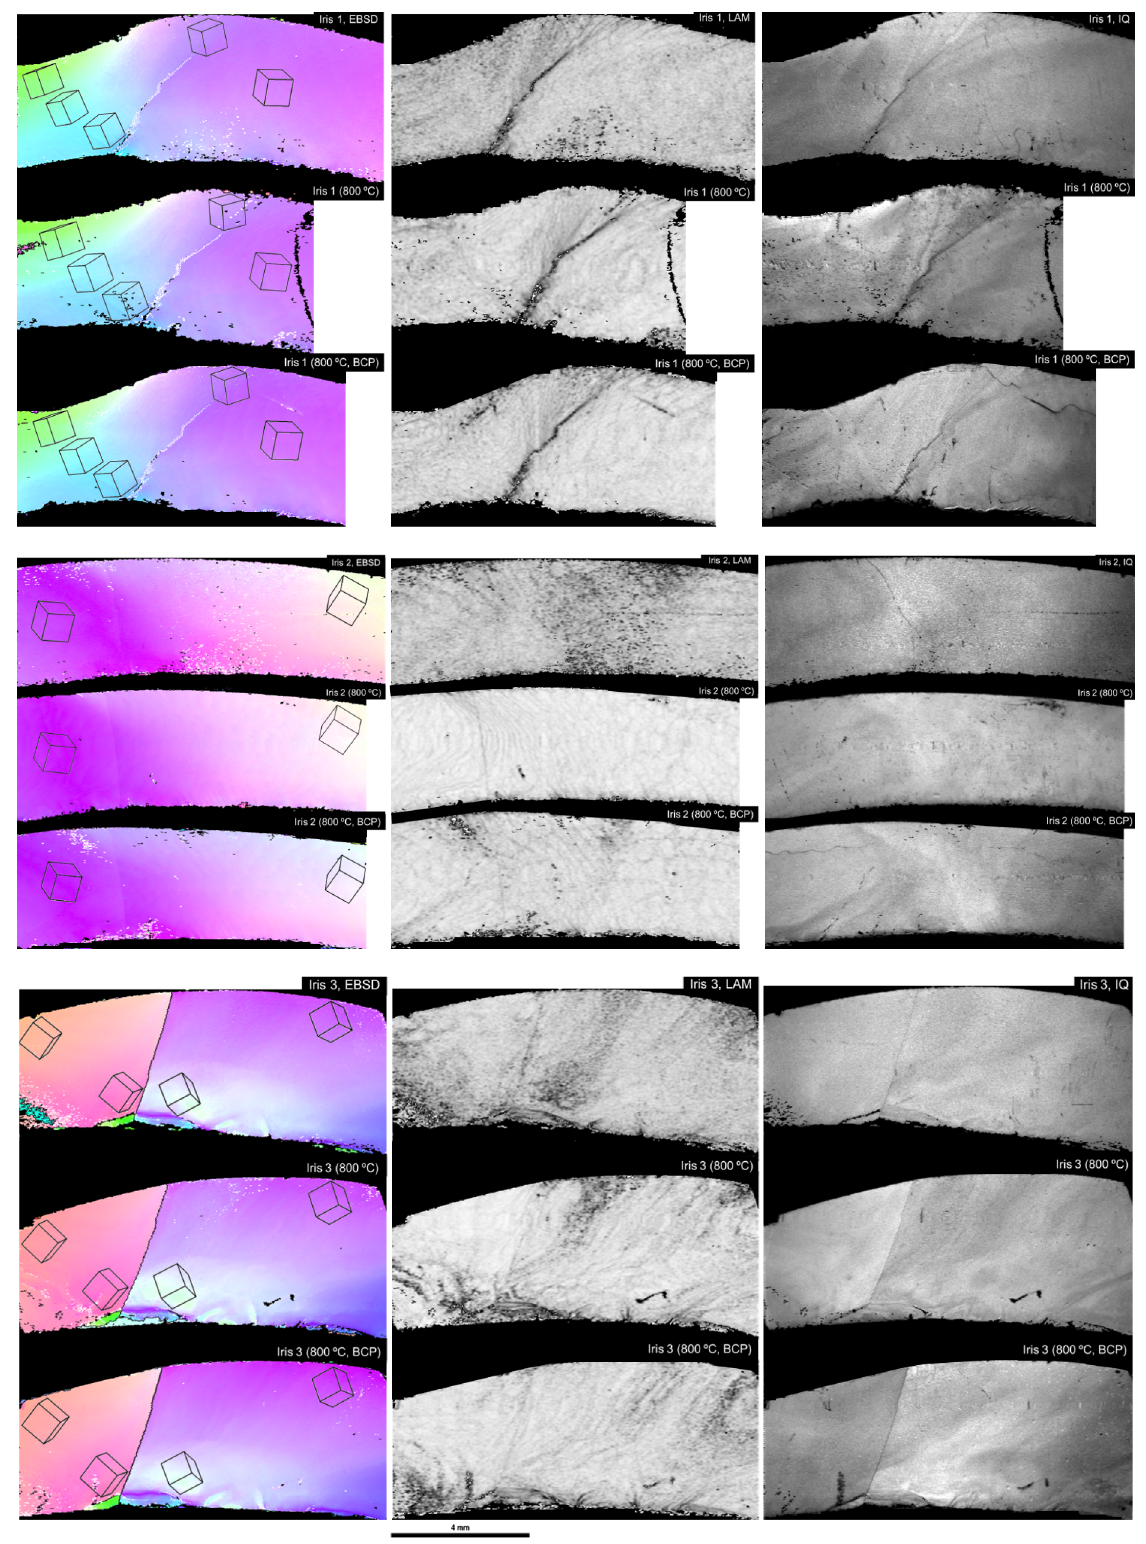
FIG. 6. Normal direction orientation maps (left), LAM maps (middle), and IQ maps (right) for the three iris scans. For each area, results for as-deep drawn, after heat treatment, and after BCP are shown from top to bottom. Scale is common and legends are the same as those in Fig.